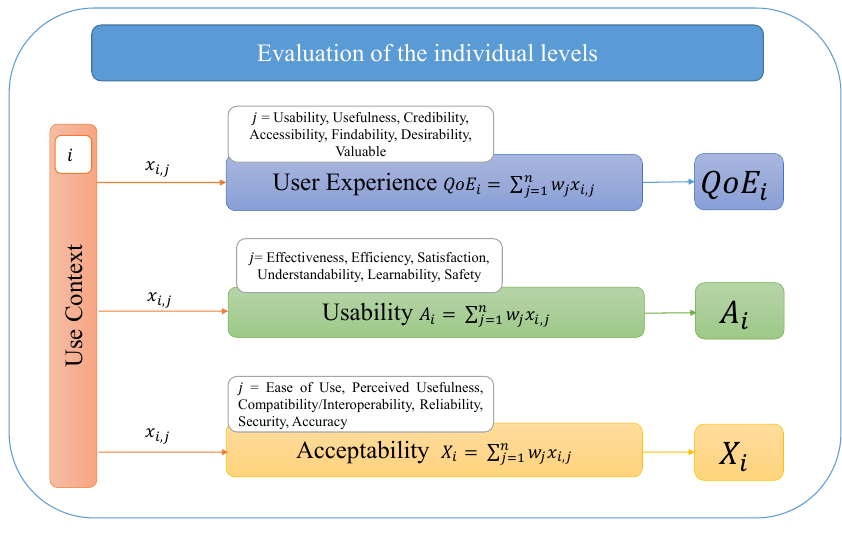
Figure 5. Evaluation of the individual levels. The figure shows the different outputs of the different individual levels and the role of the use context in the definition of the attributes’ weights.